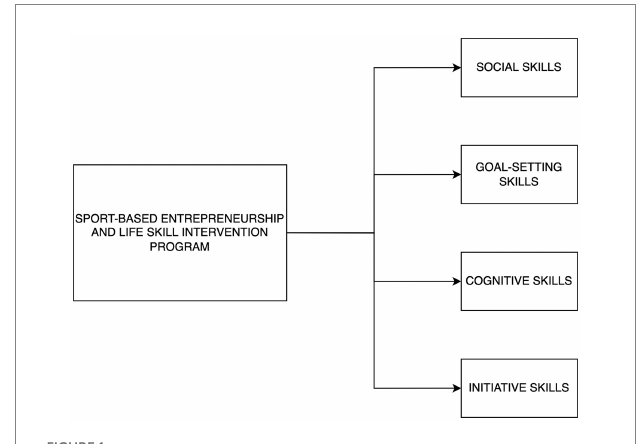
FIGURE 1 Conceptual